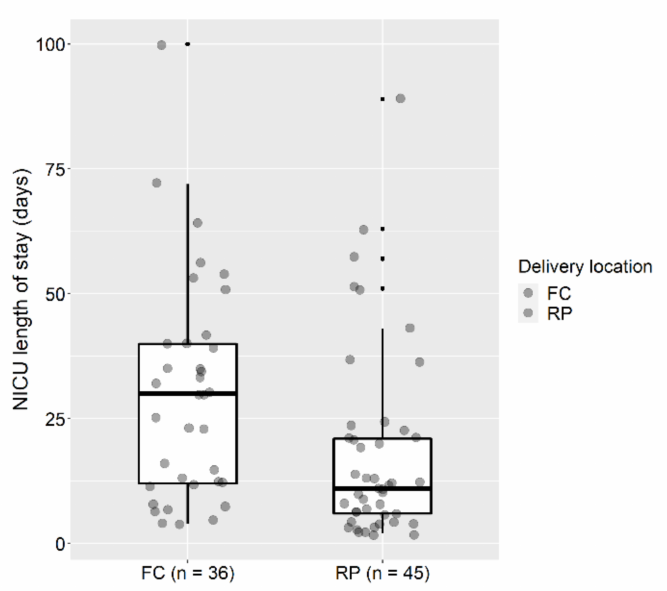
Figure 2. Length of stay (days) versus delivery location in 81 patients who underwent prenatal myelomeningocele repair. FC, fetal center; RP, referring